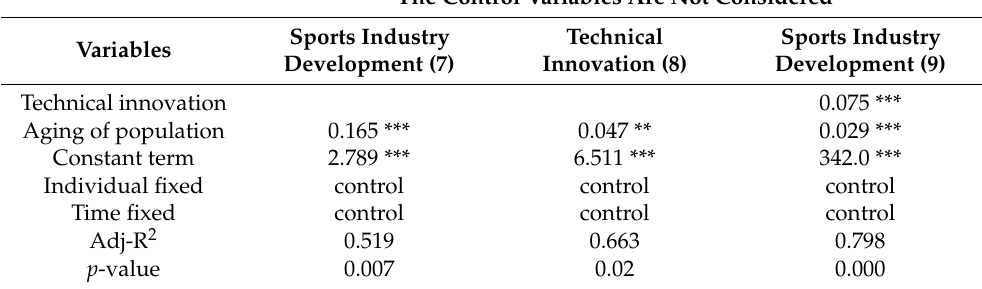
Table 4. Results of the robustness test of the intermediary effect of the impact of population aging on the development of the sports